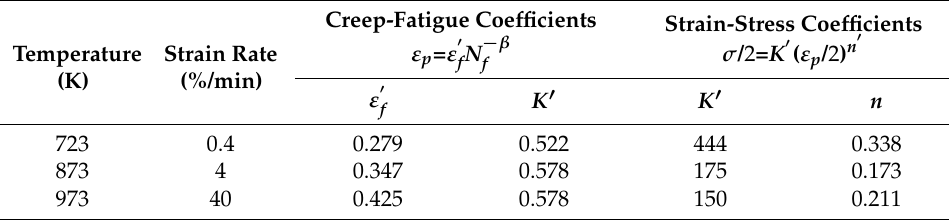
Figure 4. Creep-rupture characteristics of stainless steel 316. Table 4. Creep-fatigue data for stainless steel 316.